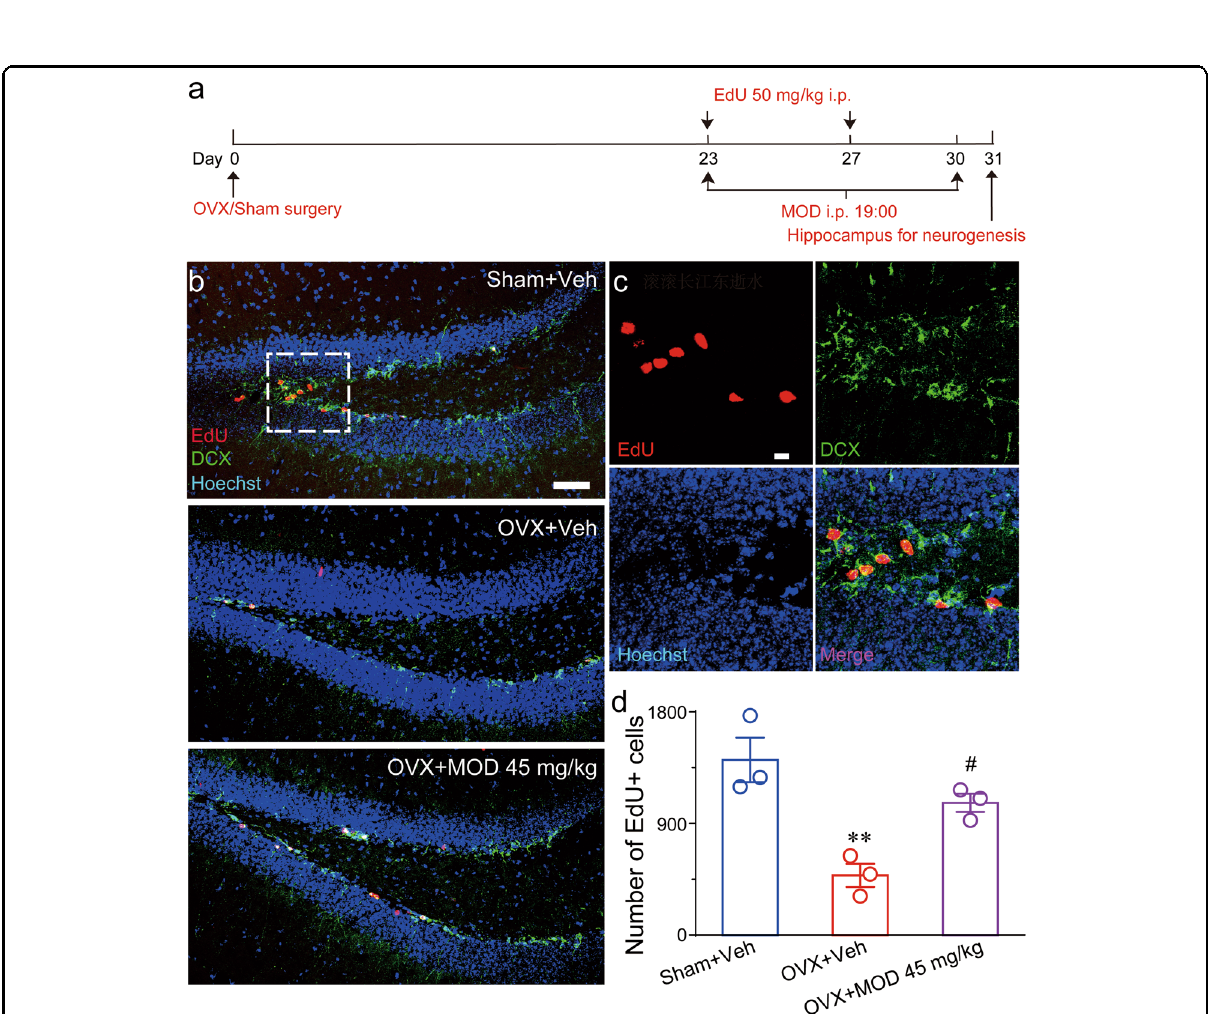
Fig. 4 Moda fi nil ameliorates ovariectomy-induced reductions of newborn neurons in the hippocampal dentate gyrus. a Experimental design for neurogenesis staining. b Representative images of EdU/DCX immunostaining in the dentate gyrus in mice of each group. Scale bar: 50 μ m. c Higher-magni fi cation images of the area marked by the frame in ( b ). Scale bar: 20 μ m. d Quanti fi cation of EdU + cells generated during the eight- day moda fi nil (MOD) treatment [ F (2,6) = 14.2, p = 0.0053]. n = 3 per group. ** p < 0.01 compared with the Sham + Vehicle (Veh) group; # p < 0.05 compared with ovariectomy (OVX) + Veh group. EdU 5-ethynyl-2 ′ -deoxyuridine, DCX